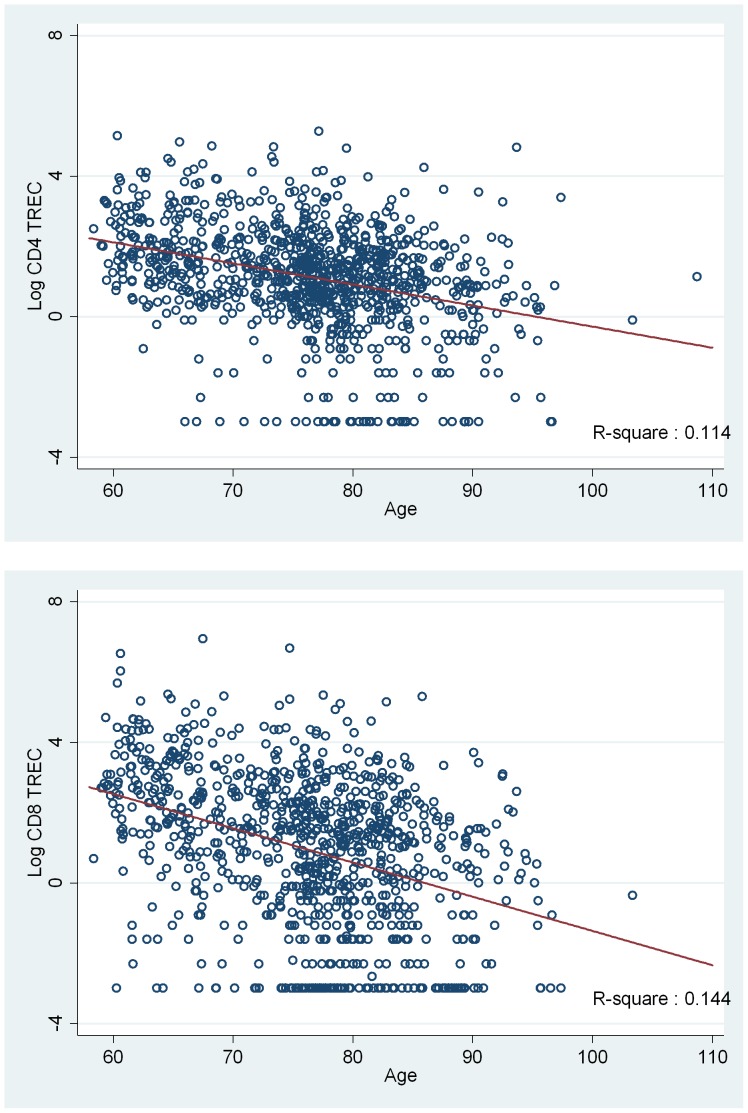
TREC numbers and age among aging atomic-bomb survivors.Scatter diagrams of age at the time of examination and CD4 TRECs or CD8 TRECs. Each dot represents a single subject. Regression lines and r-square values in simple linear regression are indicated. TREC stands for T-cell receptor excision circle.